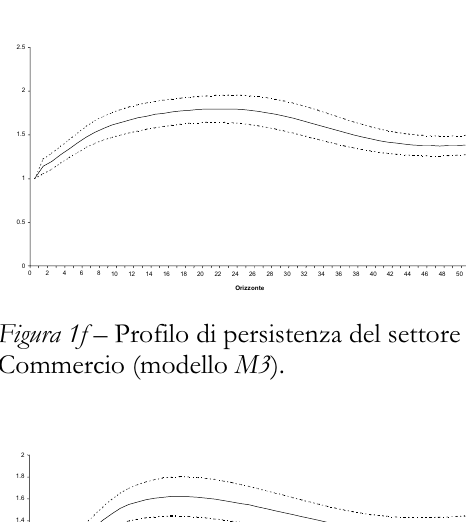
Figura 1c – Profilo di persistenza del settore Beni Durevoli (modello M3 ).